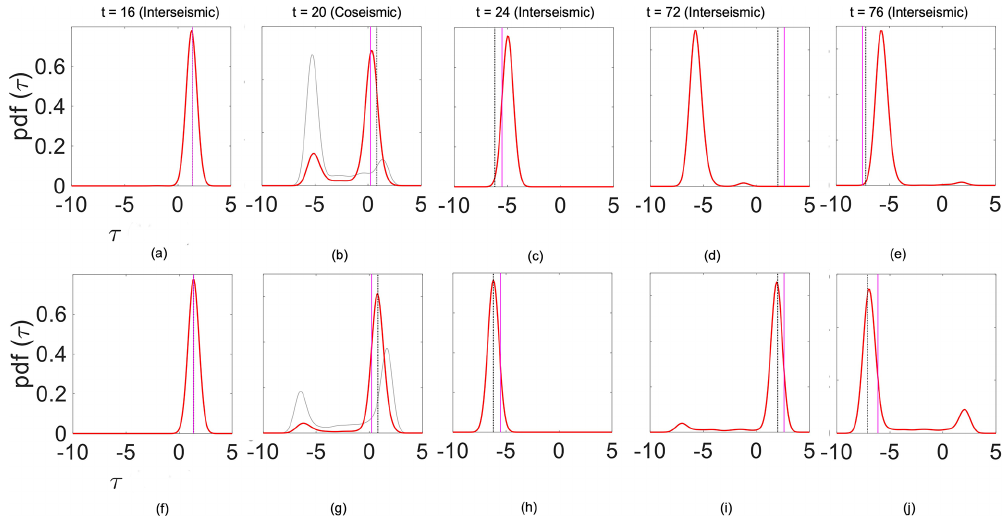
Figure 7. The pdfs representing the posterior mean (red), the prior (gray line), the observation (magenta) and the truth (black line) for the case illustrated in Fig.